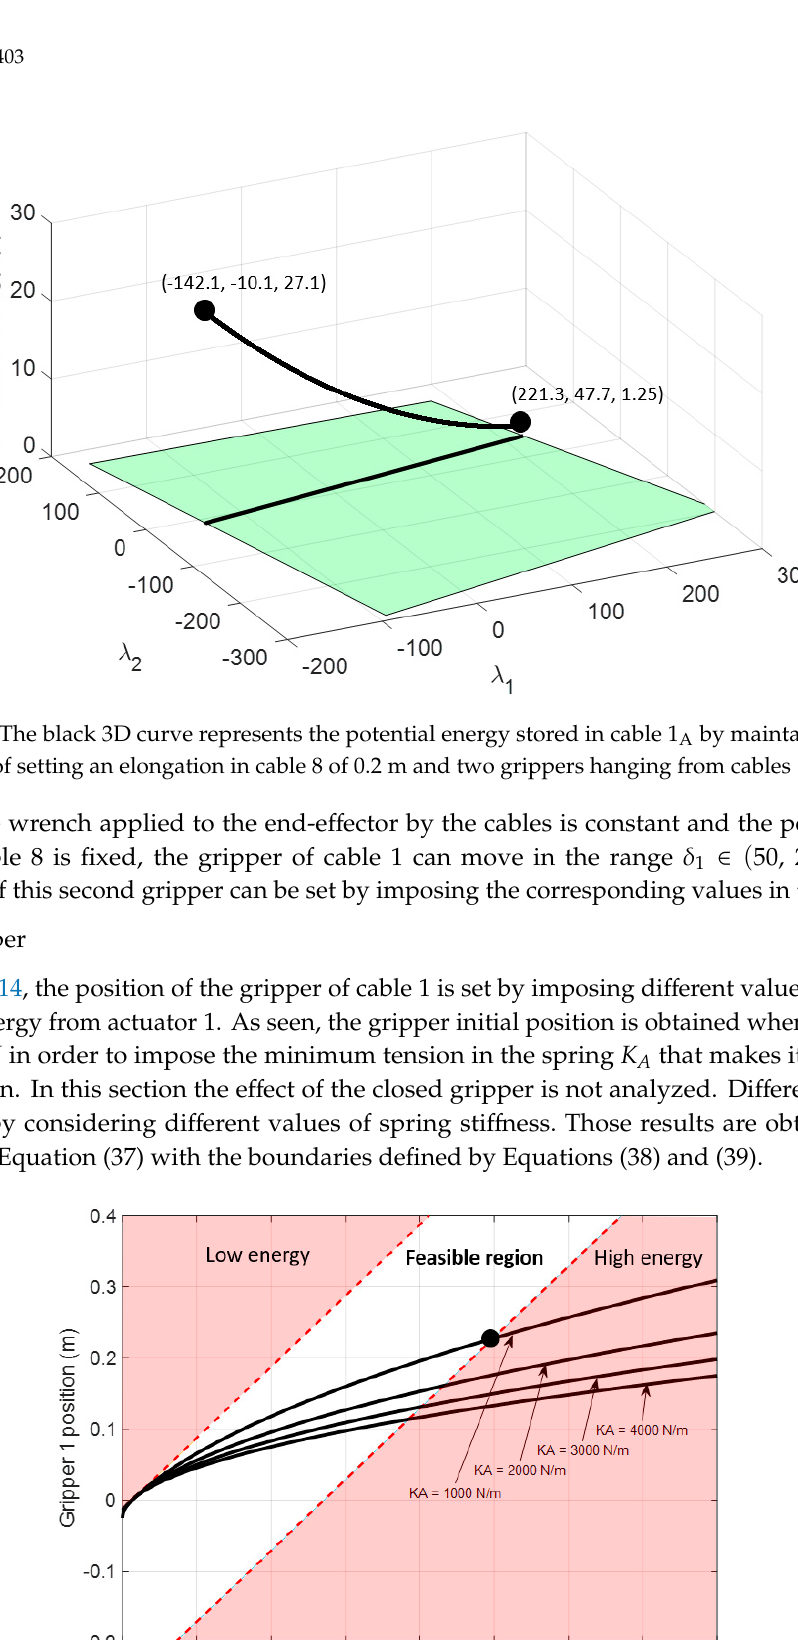
Figure 14. Feasible region of the energy imposed by actuator 1 for setting the position of the gripper attached to its compliant actuator. The range of feasible energy imposed by the actuator is related to the tension range available in the springs. Four di ff erent spring sti ff ness were analyzed for cable section 1 A . Boundaries were applied for the case of K A = 1000 N/m .